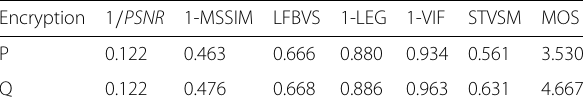
Table 5 Objective and subjective evaluation results for encryption cases in Fig.